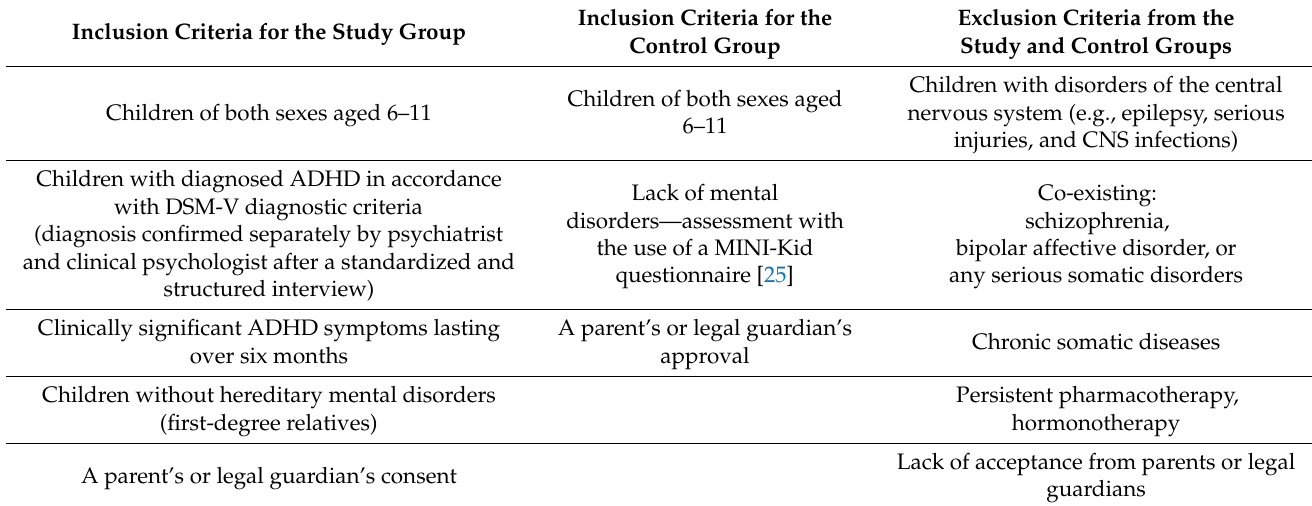
Table 1. Inclusion and exclusion criteria for both